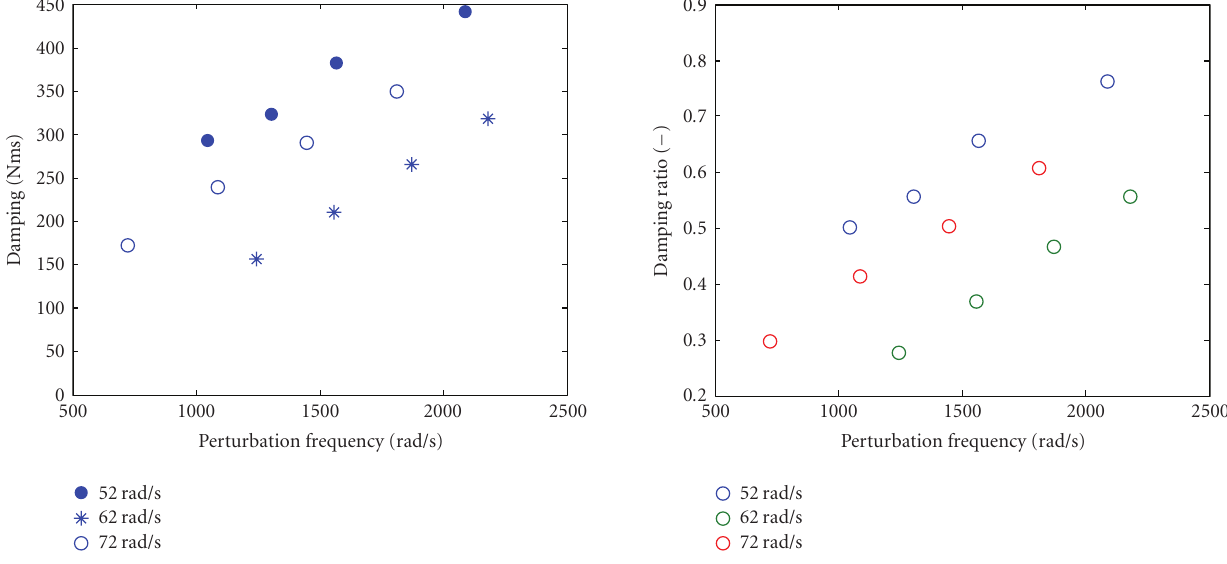
Figure 8: Additional damping due to the flow through the turbine (the damping of the mechanical system is